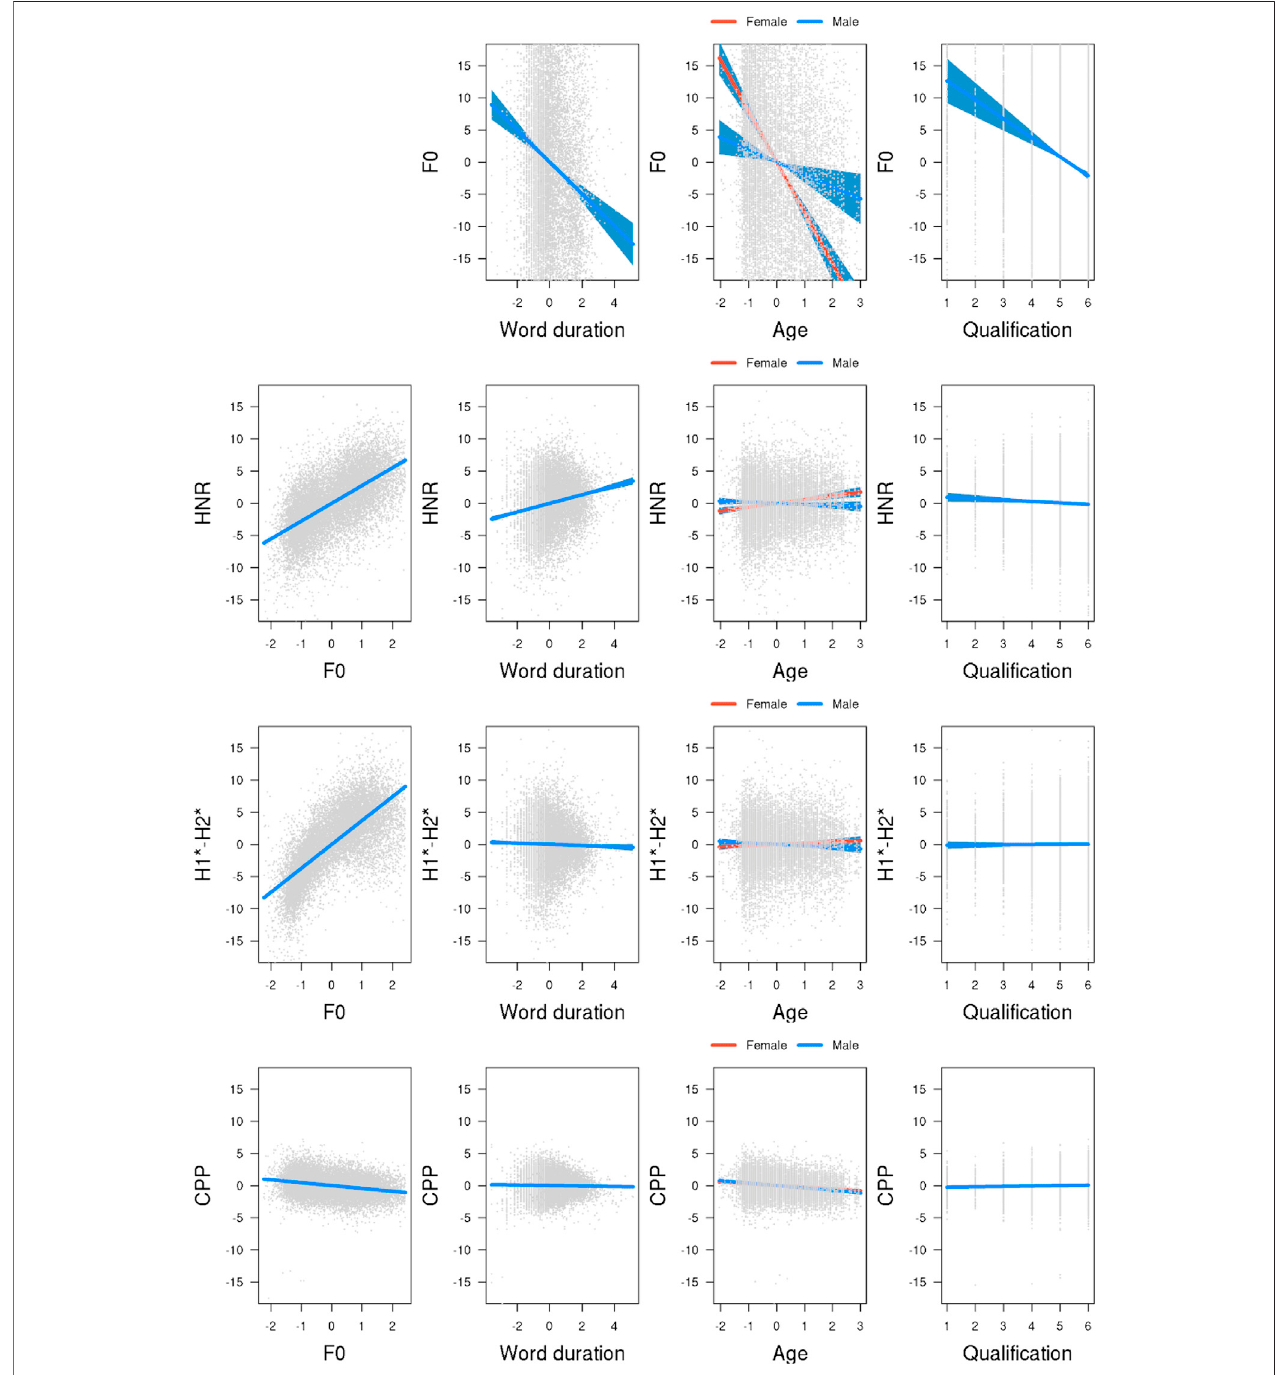
FIGURE2| Modelestimatesforthefourmeasuresofmodalvoice.Firstrow:F0,secondrow:HNR,thirdrow:H1*-H2*,bottomrow:CPP.Predictorsareillustrated in the columns (adapted from Garellek (2012)).